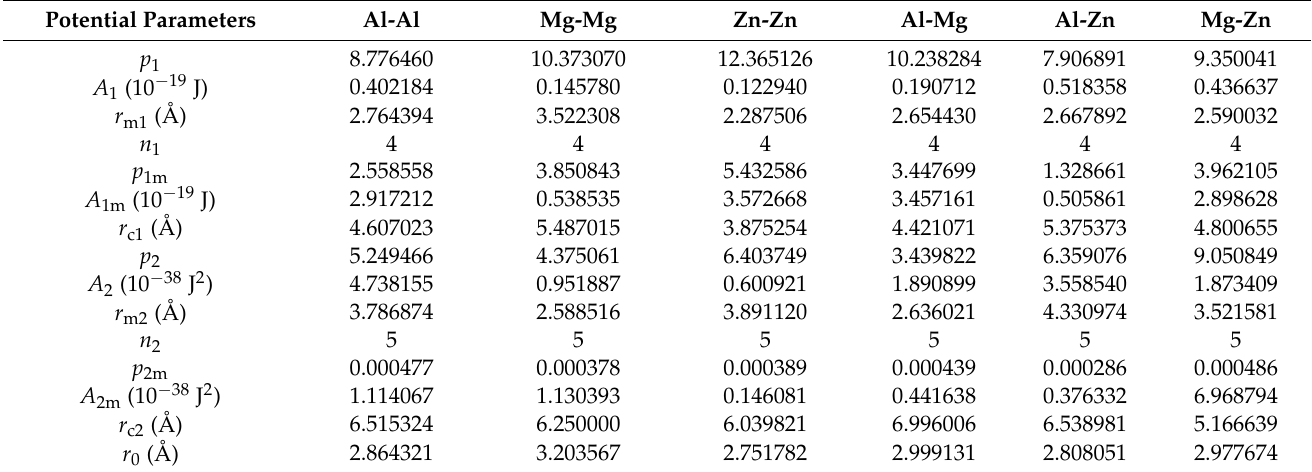
Table 1. The potential parameters for the Al-Mg-Zn system.